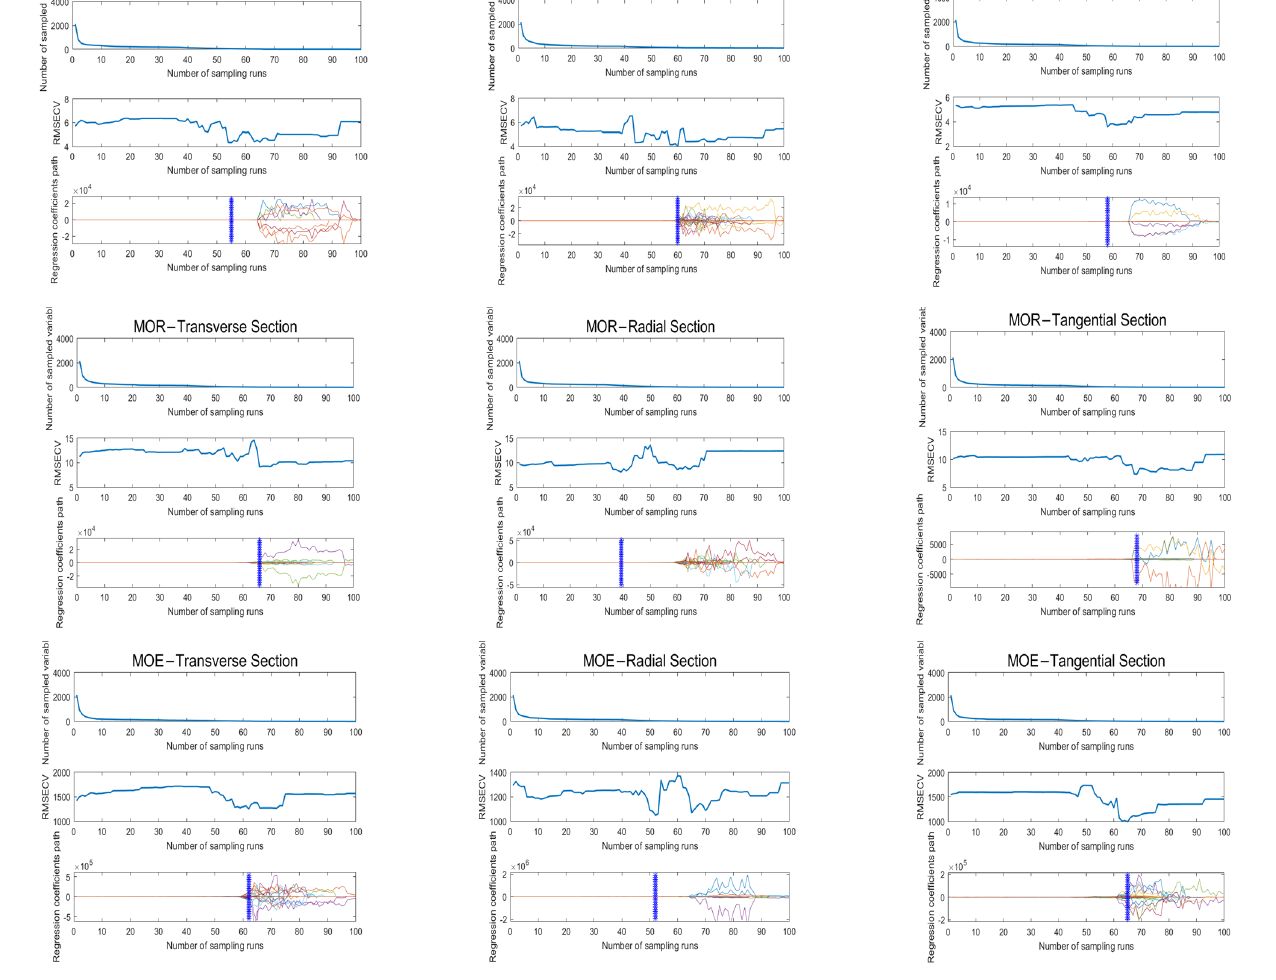
Figure 7. Band screening results of wood mechanical properties Vis ‐ NIRS based on CARS.